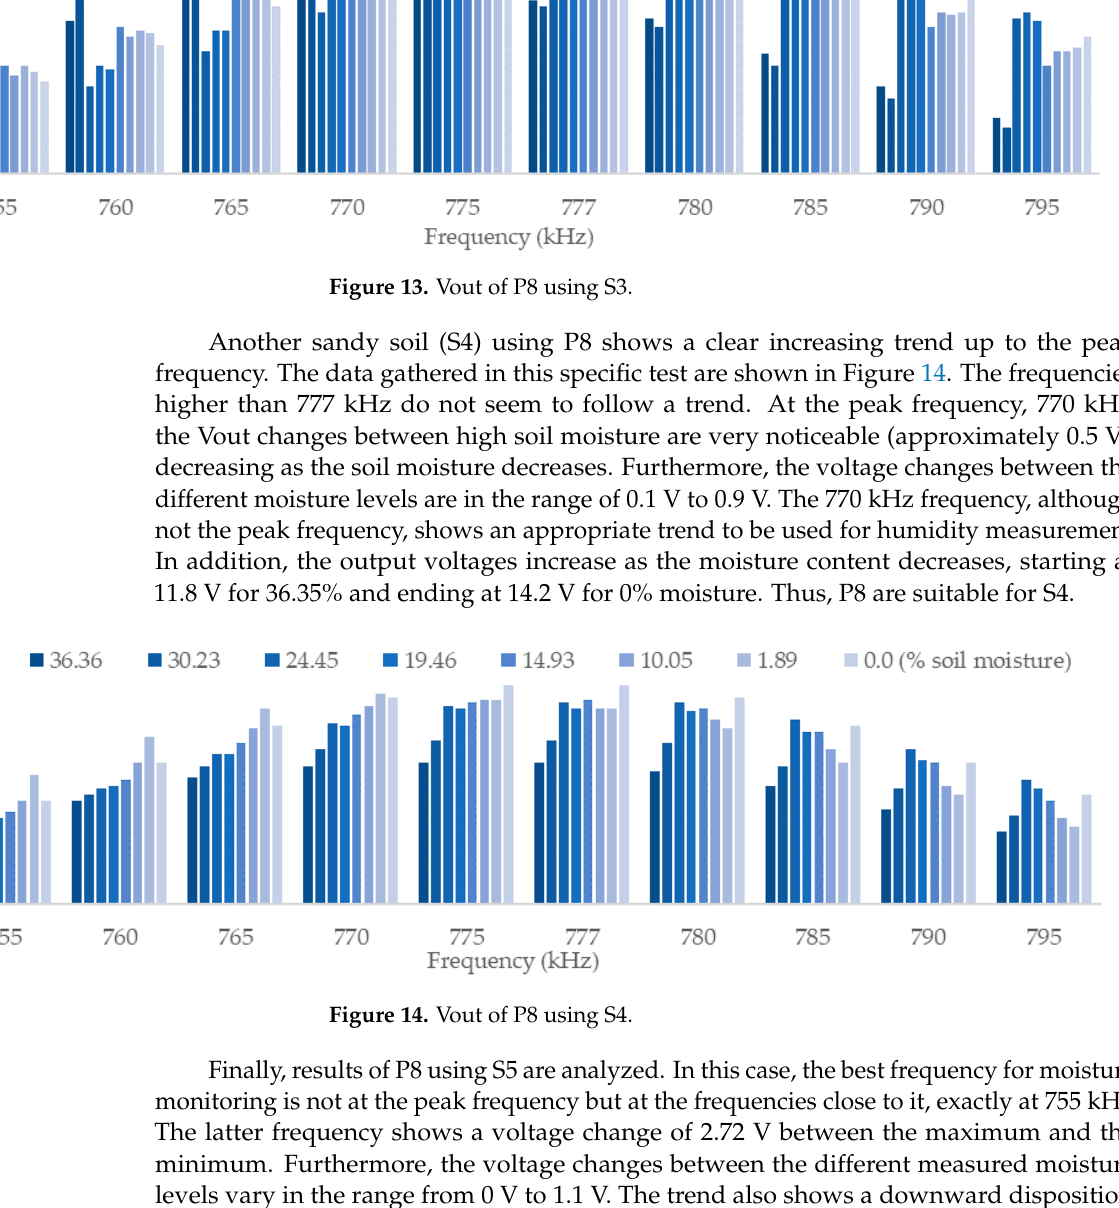
Figure 15. Vout of P8 using S5.